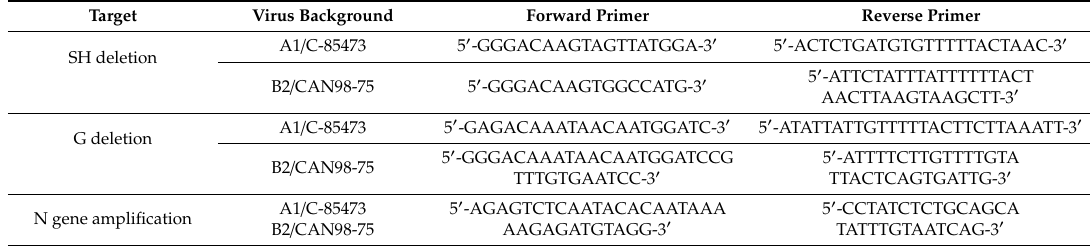
Table 1. List of